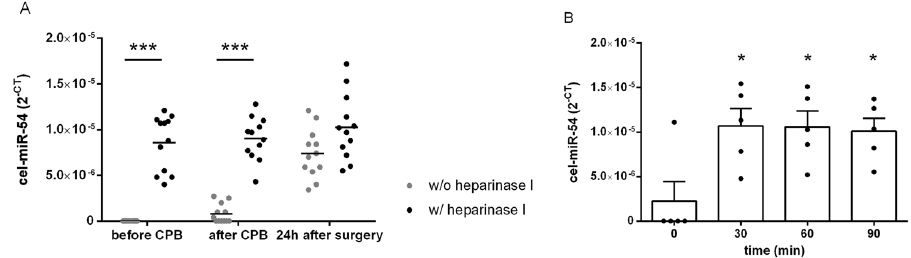
Figure 1. Plasma cel-miR-54 expression in samples from patients undergoing CABG. ( A ) Effect of heparinase I incubation on relative plasma cel-miR-54 concentrations (2 − CT ). Cel-miR-54 expression was determined by qPCR (n = 12). RNA samples before and after CPB, and from 24 h after surgery were either untreated or treated with 1 U heparinase I prior to reverse transcription and qPCR. Statistics: Repeated measure ANOVA followed by post hoc t-tests; *** P < 0.001. ( B ) Relative plasma cel-miR-54 concentrations (2 − CT ) in samples before CPB after heparinase I treatment for different time periods. Prior to reverse transcription, miRNA samples were incubated with heparinase I for the indicated time periods and then analysed for cel-miR-54 expression by qPCR (n = 5). Statistics: One-way ANOVA followed by Dunnett’s post hoc test; * P < 0.05 vs. 0